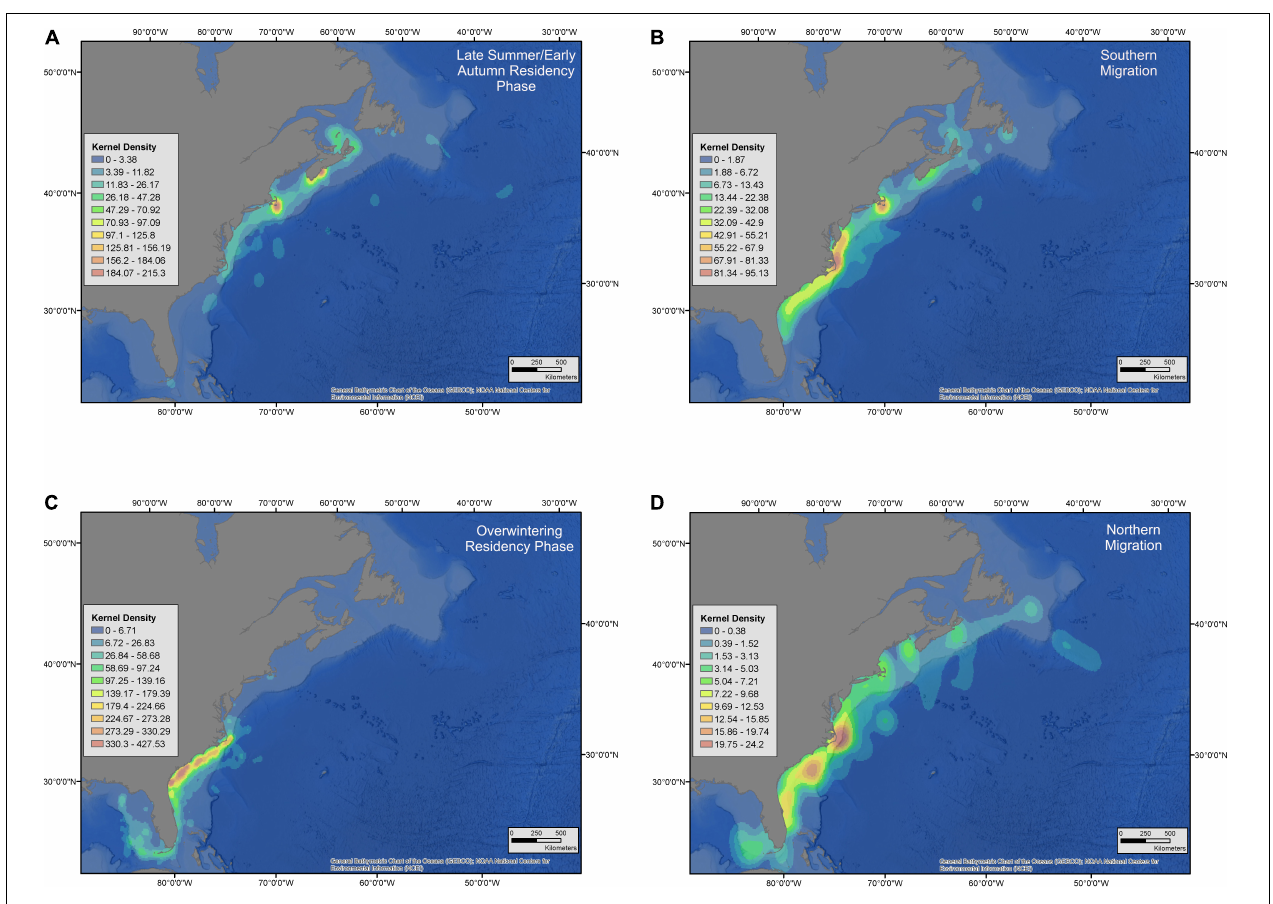
FIGURE 6 | Kernel density distributions by behavioral season of white sharks in the western North Atlantic. Interpolated kernel density distributions are derived from regularized tracks built from SPOT and acoustic locations. Data is pooled among all years, sexes, and age classes except for adult female sharks. Panels are segmented by behavioral state/season: Late summer/early autumn ( A: 1 July – 15 October), southern migration ( B: 16 October – 30 November), overwintering ( C: 1 December – 15 May), northern migration ( D: 16 May – 30